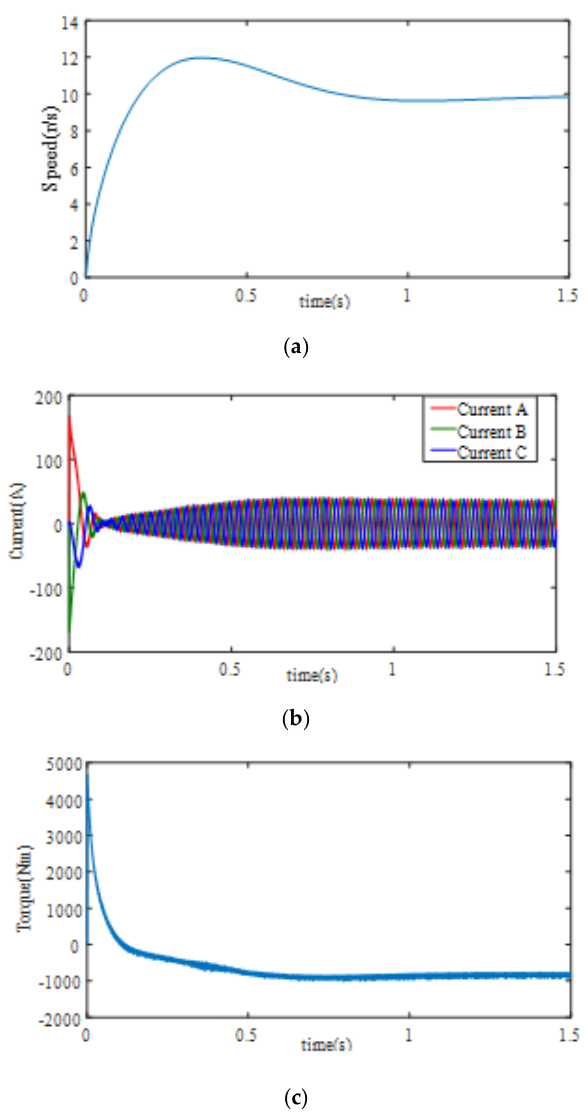
Figure 34. Generator power generation characteristic curve based on the experiment; ( a ) Generator speed curve; ( b ) Generator current curve; ( c ) Generator torque curve.